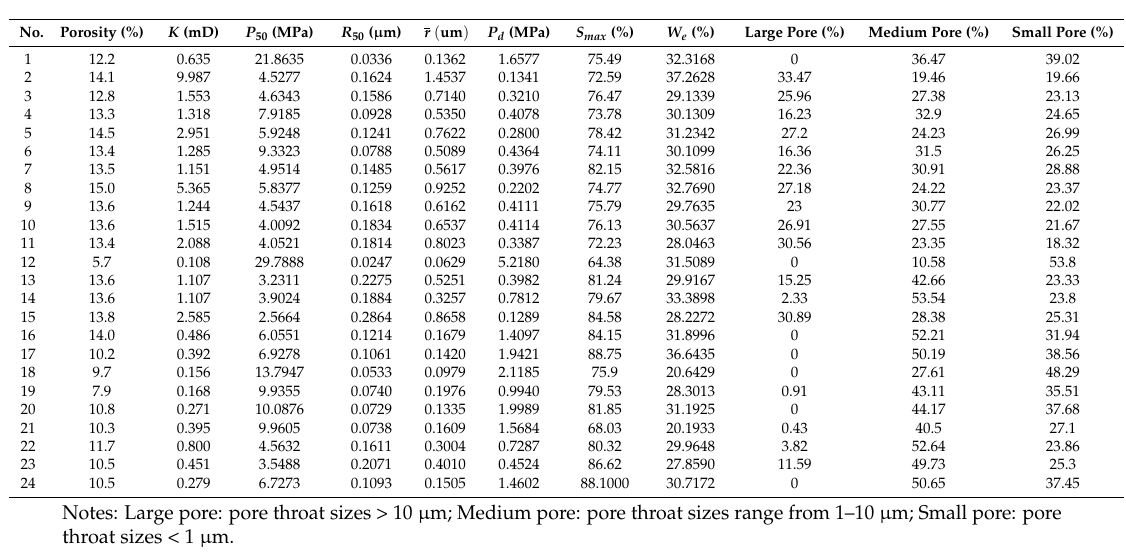
Table 1. The porosity, permeability and mercury injection capillary pressure (MICP) parameters of samples.